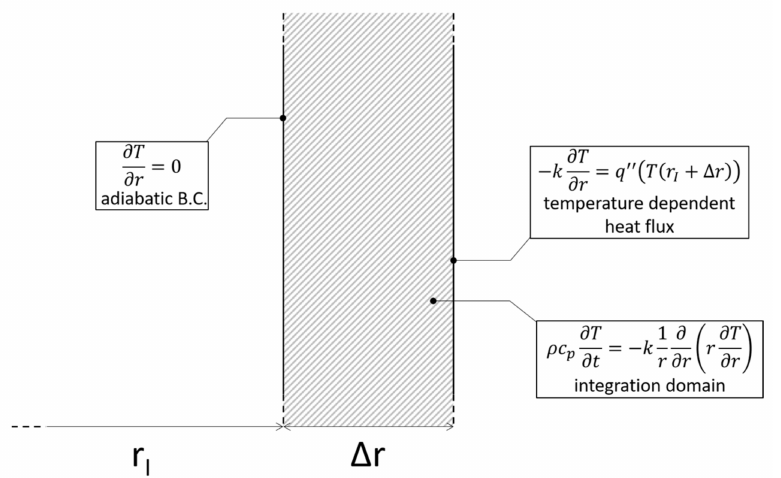
Figure 10. Solution domain for the simplified model for the evaluation of the suitability of the emitter-lumped